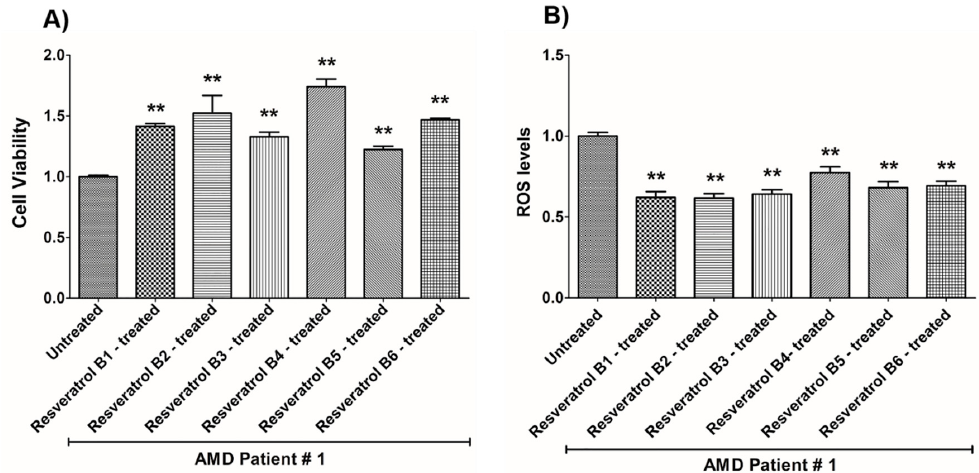
Figure 2. E ff ects of resveratrol formulations on cell viability ( A ) and ROS levels ( B ) in AMD patient #1. Bar 1—untreated AMD cells; Bar 2—resveratrol B1-treated AMD cells; Bar 3—resveratrol B2-treated AMD cells; Bar 4—resveratrol B3-treated AMD cells; Bar 5—resveratrol B4-treated AMD cells; Bar 6—resveratrol B5-treated AMD cells; Bar 7—resveratrol B6-treated AMD cells. Data are presented as mean ± SEM; ** p <